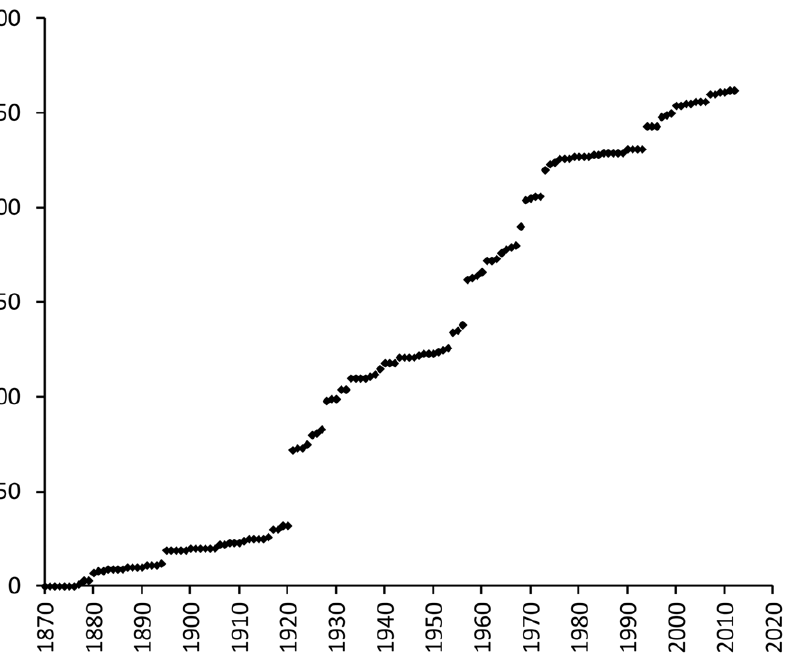
Figure 4. Gymnodinium species discovery curve. This figure shows the accumulated number of species of Gymnodinium known to science over time.